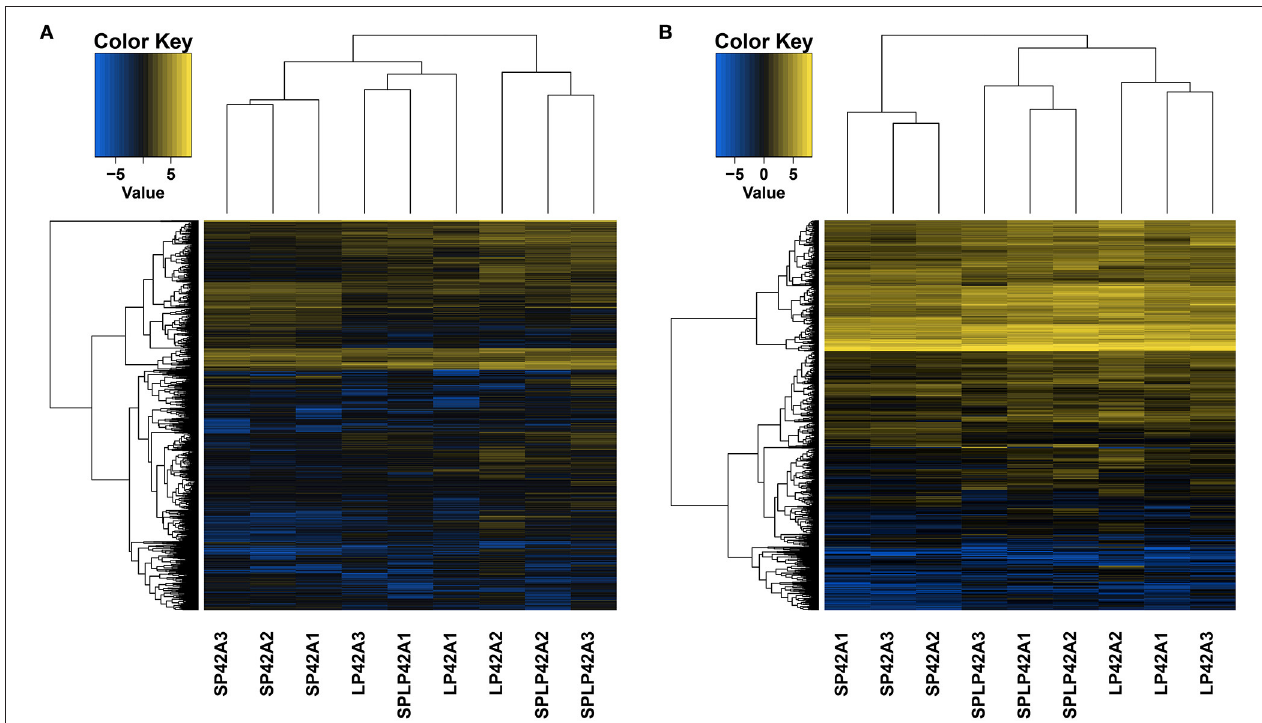
FIGURE 3 | The differentially expressed lncRNAs and mRNAs in each sample using Heat maps. According to a base logarithm of 2 of expression about DEMs and DELs in each sample and the Euclidean distance was calculated, and then the overall clustering results of the samples were obtained by systematic clustering method (Hierarchical Cluster), (A) lncRNAs, (B) mRNAs.